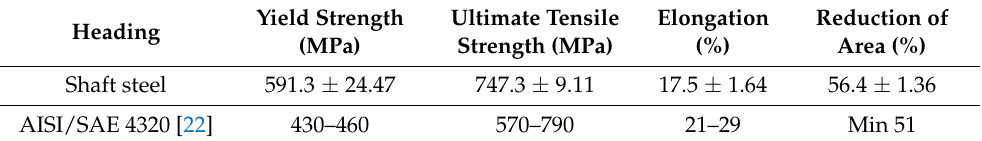
Table 5. Tensile test results.